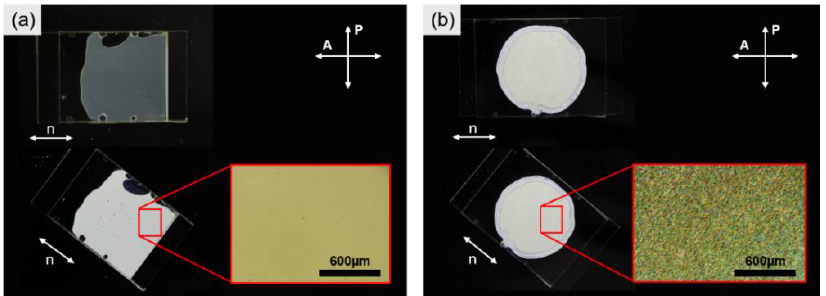
Figure 3. Alignment of LCEs observed between the crossed polarizers and under a POM (inset): ( a ) monodomain LCE and ( b ) polydomain LCE.